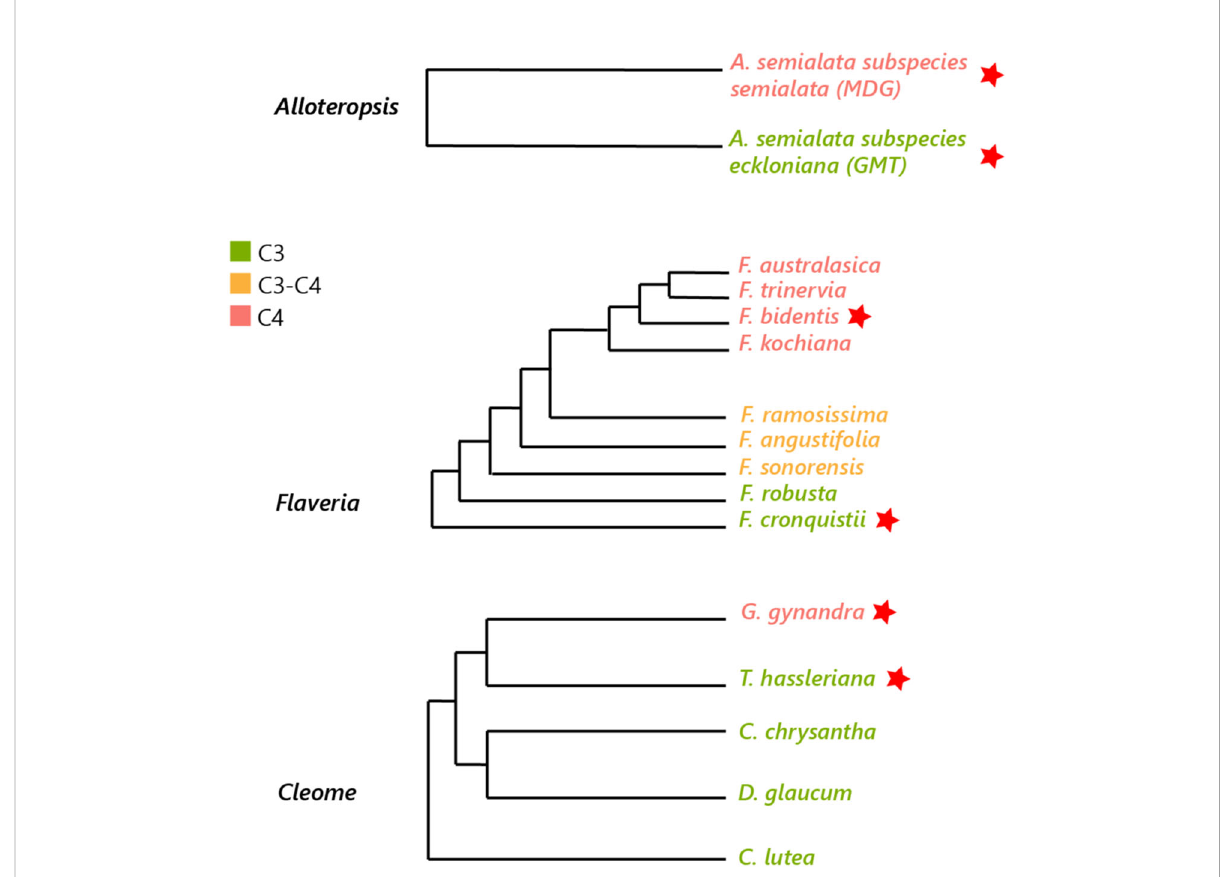
FIGURE 1 Phylogenetic tree of Alloteropsis , Flaveria and Cleome genera. Species used in the study are marked with a red star (adapted from Ibrahim et al., 2009; Lyu et al., 2015; Shi et al.,